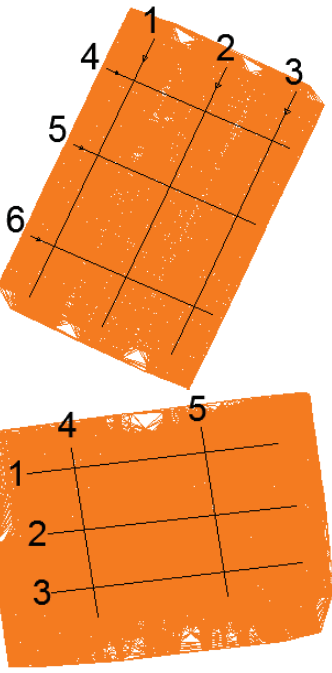
Figure 11. The First and Second Study Area's Profiles It also shows the missing details, such as holes or small bumps on the surfaces.